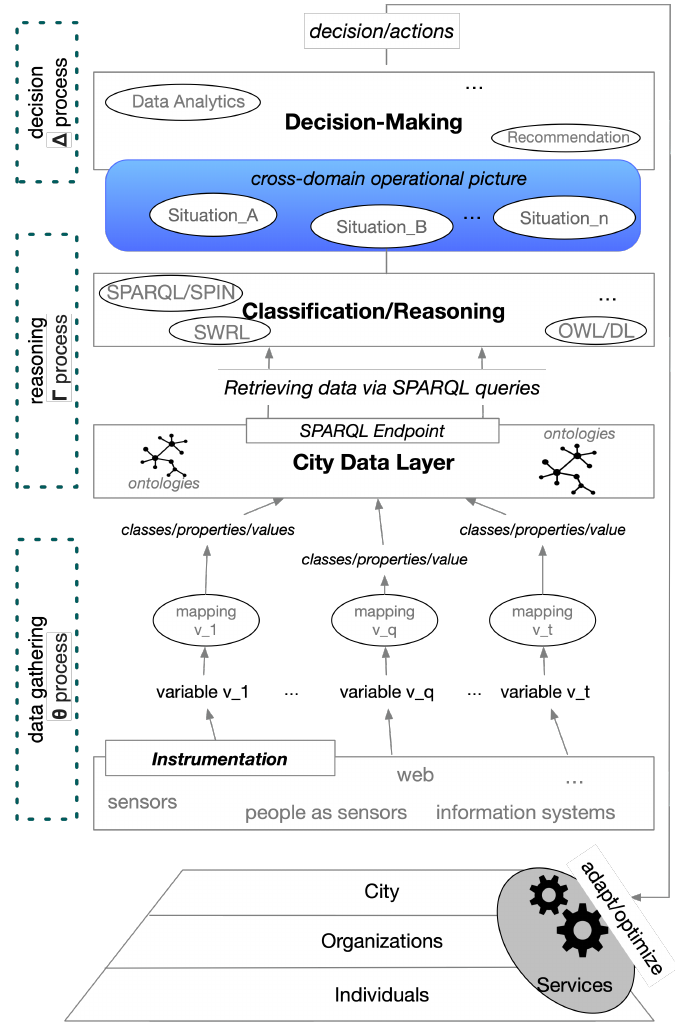
Figure 2. Smart City Service System: